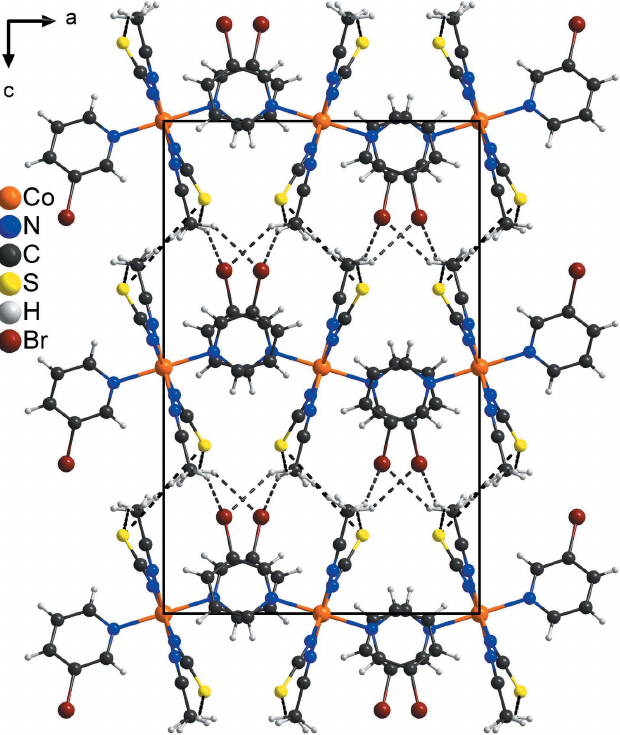
Figure 2 Crystal structure of the title compound with view along the crystal- lographic b -axis and intermolecular C—H (cid:2)(cid:2)(cid:2) S and C—H (cid:2)(cid:2)(cid:2) Br hydrogen bonding shown as dashed lines. Please note that the methyl H atoms of the acetonitrile ligand are disordered.